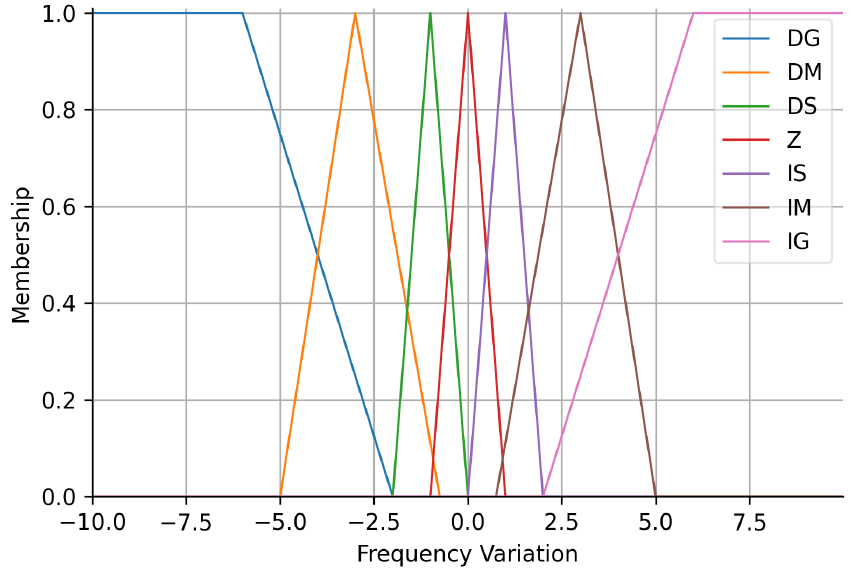
Figure 5. Membership function of the frequency variation (output